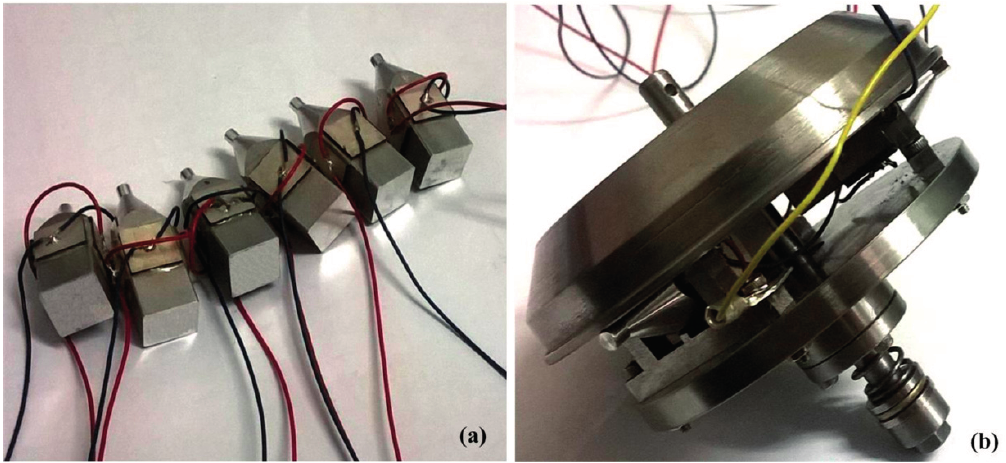
Figure 7. The prototype: ( a ) the bending transducers; ( b ) the final